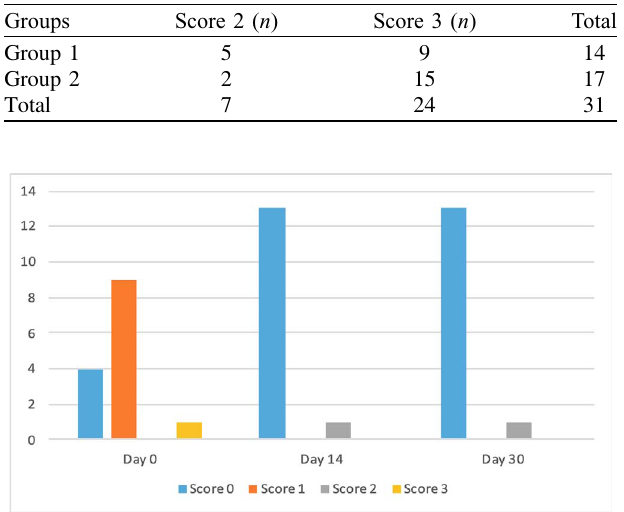
Figure 2. Number of cats according to the clinical score for pruritus in Group 1 (NexGard Combo (cid:1) ).